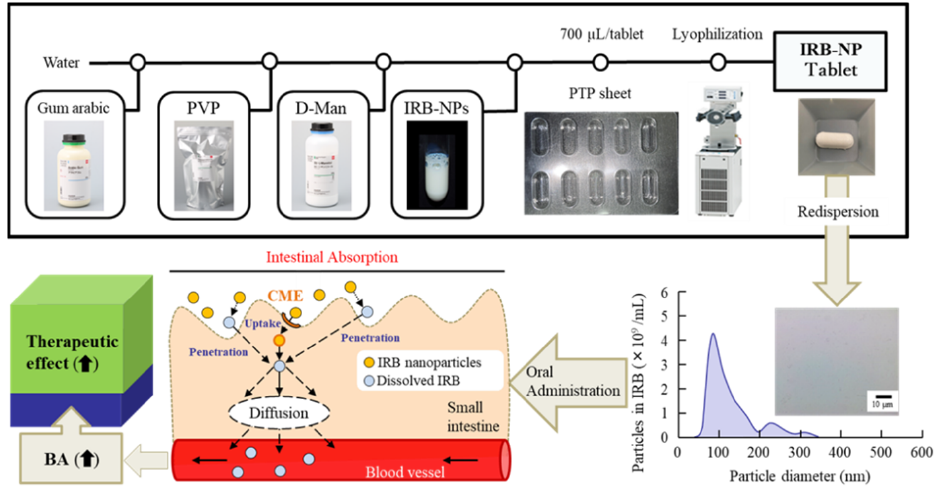
Figure 9. Scheme of the IRB-NP tablet production and intestinal absorption pathways. Supplementary Materials: The following are available online at www.mdpi.com/xxx/s1, Figure S1: Characterization of the 3-month-stored IRB-NP tablets. (A) Particle size frequencies of IRB in the